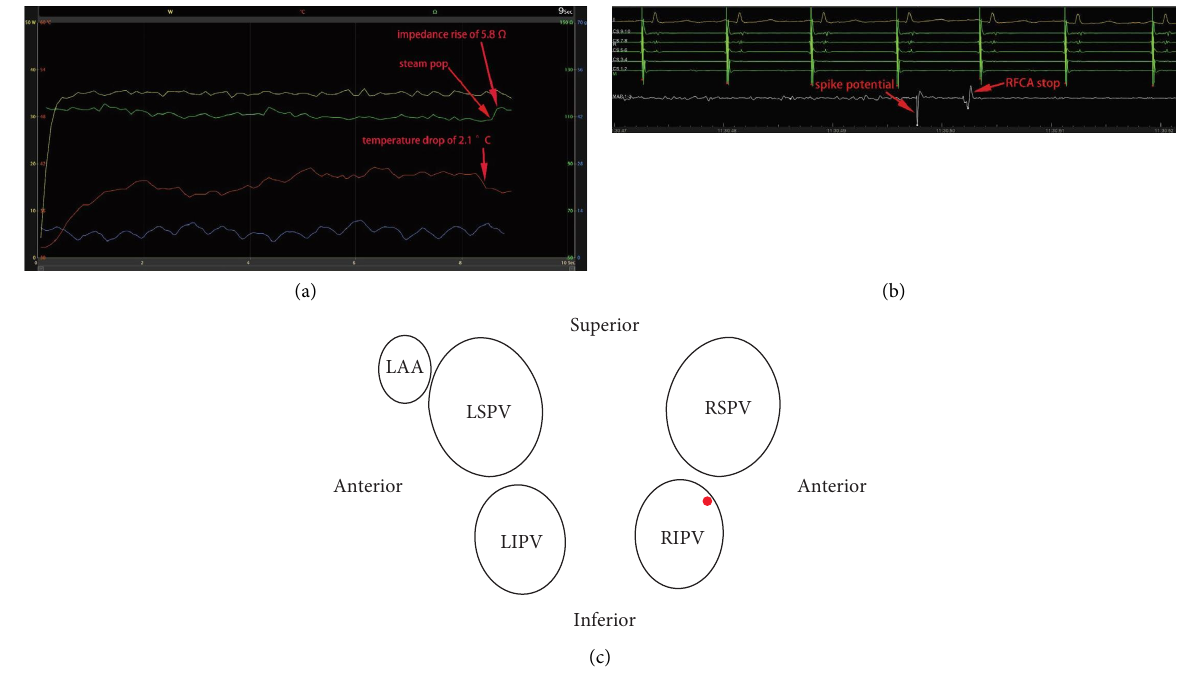
Figure 4: (a) Te time from the initiation of RFCA to the occurrence of audible SP was 8.6s. Te sudden impedance rise after 8.9s of RFCA coincided with a SP. Immediately after the SP, an abrupt impedance rise of 5.8 Ω , temperature drop of 2.1 ° C, and CF without discernible change were recorded. (b) A spike potential without consequent PAC was recorded immediately during the occurrence of SP. (c) Te location of the SP is at the anterior-superior wall of the RIPV. Table 2: Comparison of RFCA parameters between audible steam pop group and control group during pulmonary vein isolation (power: